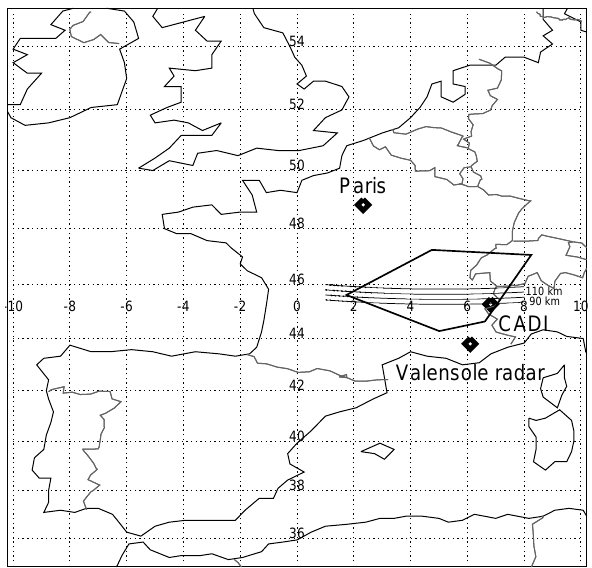
Fig. 1. Map showing the location of the Valensole HF radar and the CADI